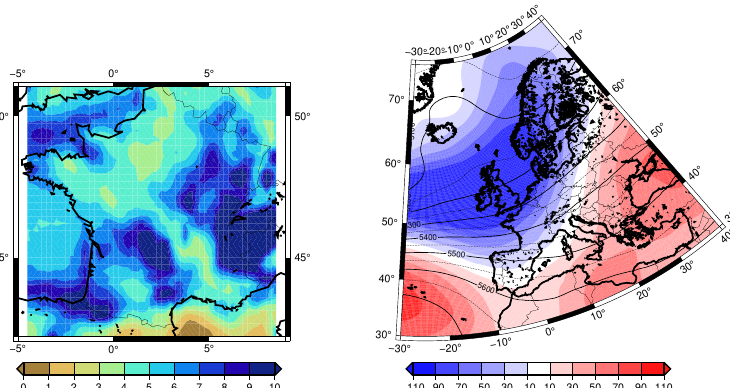
Figure 6. Left panel : mean precipitation rate (in mm/day) over France between 25 December 2017 and 9 January 2018. Right panel : mean anomalies of Z500 (in m) over the East North Atlantic region (colours). Contour lines indicate the mean Z500 (in m).